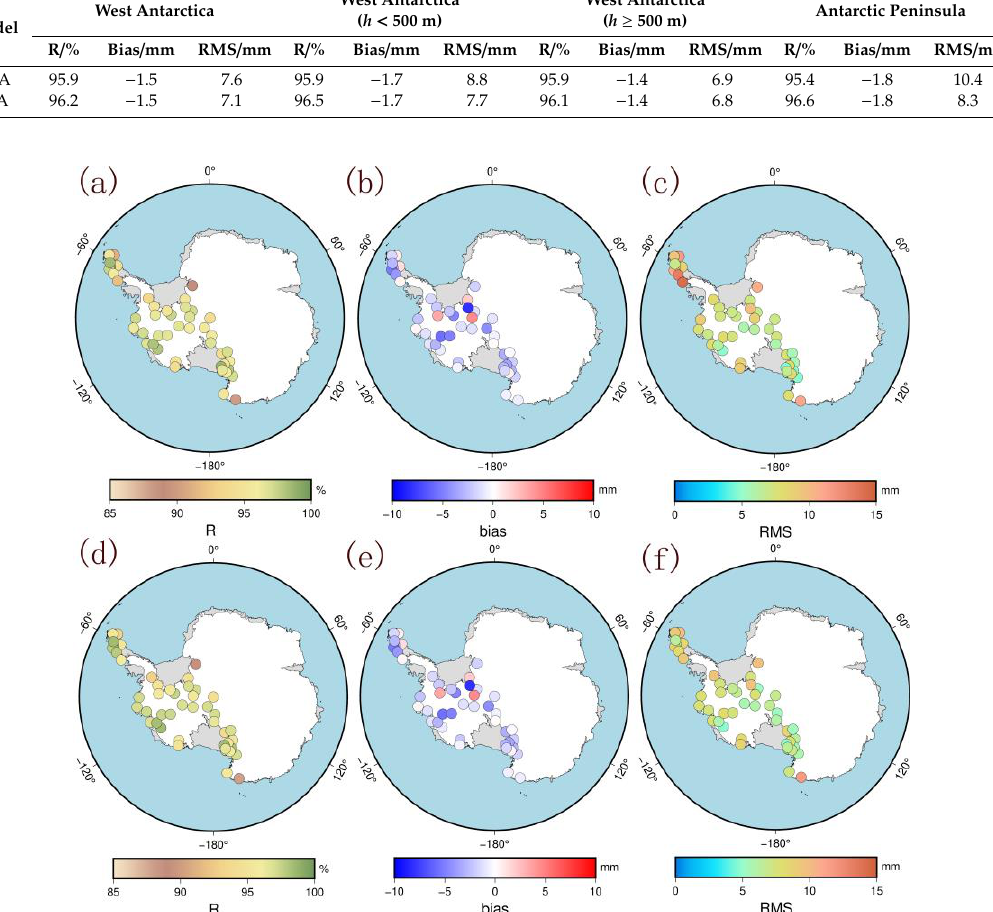
Figure 9. Distribution of the correlation coefficient R, bias, and RMS of the ZTD models and GPS-ZTD (( a ), ( b) and ( c) are the result of PCA; ( d) , ( e) and ( f) are the result of ICA).